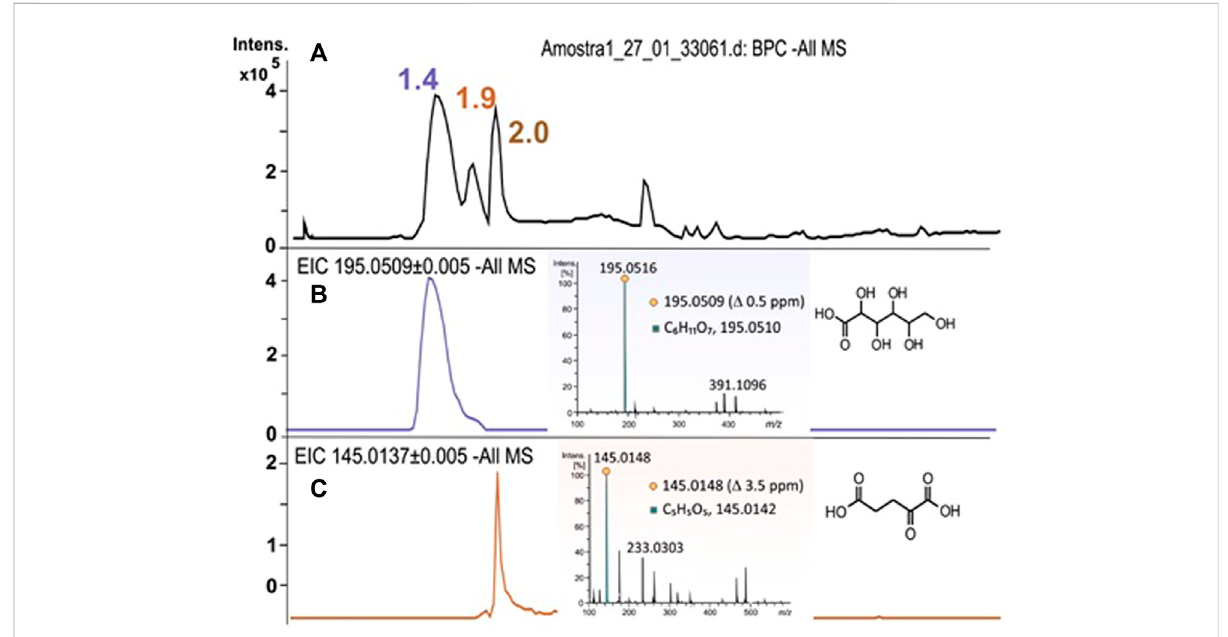
FIGURE 4 LC-HRMSanalysisofanaliquotoftheculturemediumofthecultivationof H.boliviensis onglucose: (A) Totalionchromatogramobtainedinthe ESI-negative mode; the extracted ion chromatogram and HRMS spectrum for the deprotonated molecule of (B) gluconic acid: t R 1.4 min, m/z 195.0509 ( Δ − 0.5 ppm, mSigma 5.5) (C 6 H 11 O 7 ) − and (C) 2-oxoglutaric acid: t R 1.9 min, m/z 145.0148 ( Δ − 3.5 ppm, mSigma 8.5) (C 5 H 5 O 5 ) −